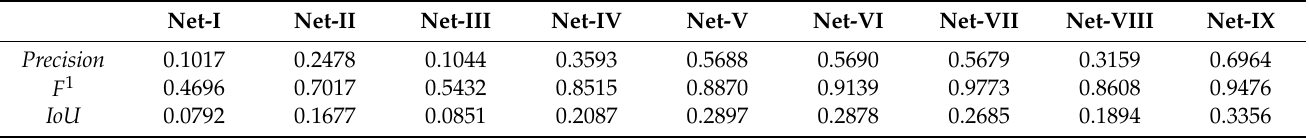
Table 19. Class metrics of cable class of testing images with the C-T ratio of